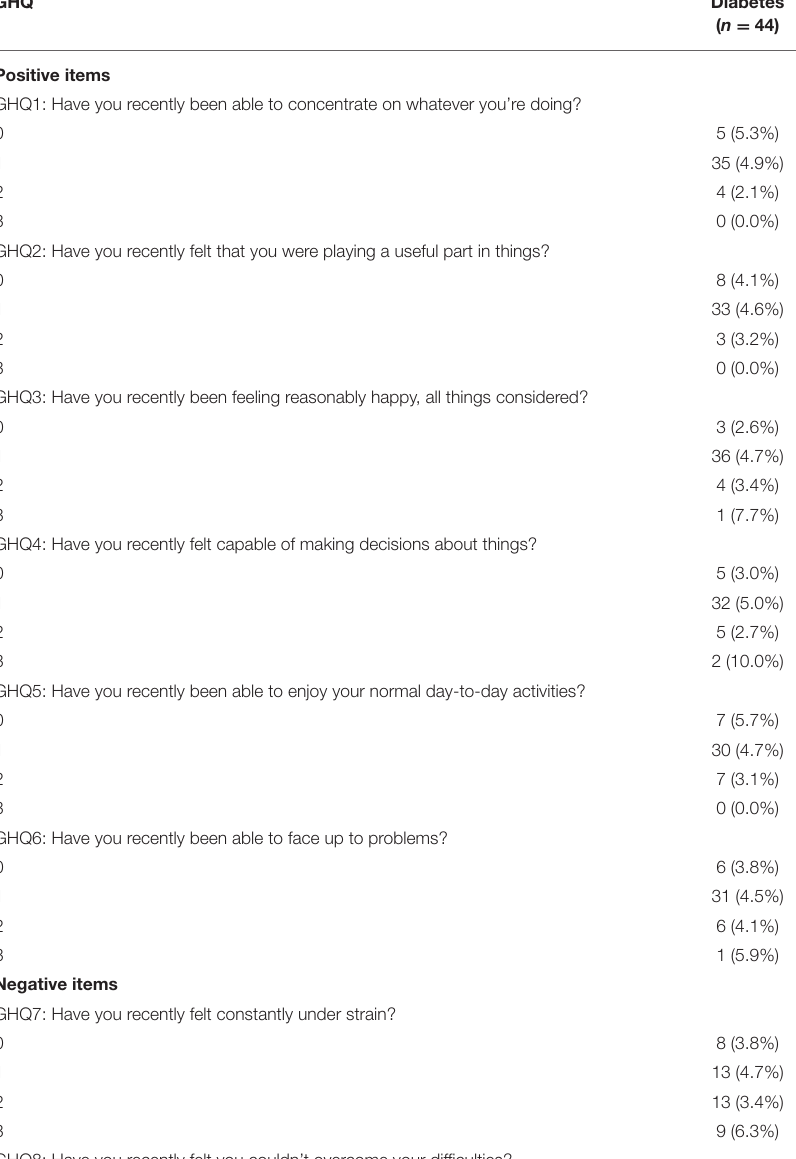
P Pre-diabetes No-diabetes ( n = 44) ( n = 230) ( n = 741)